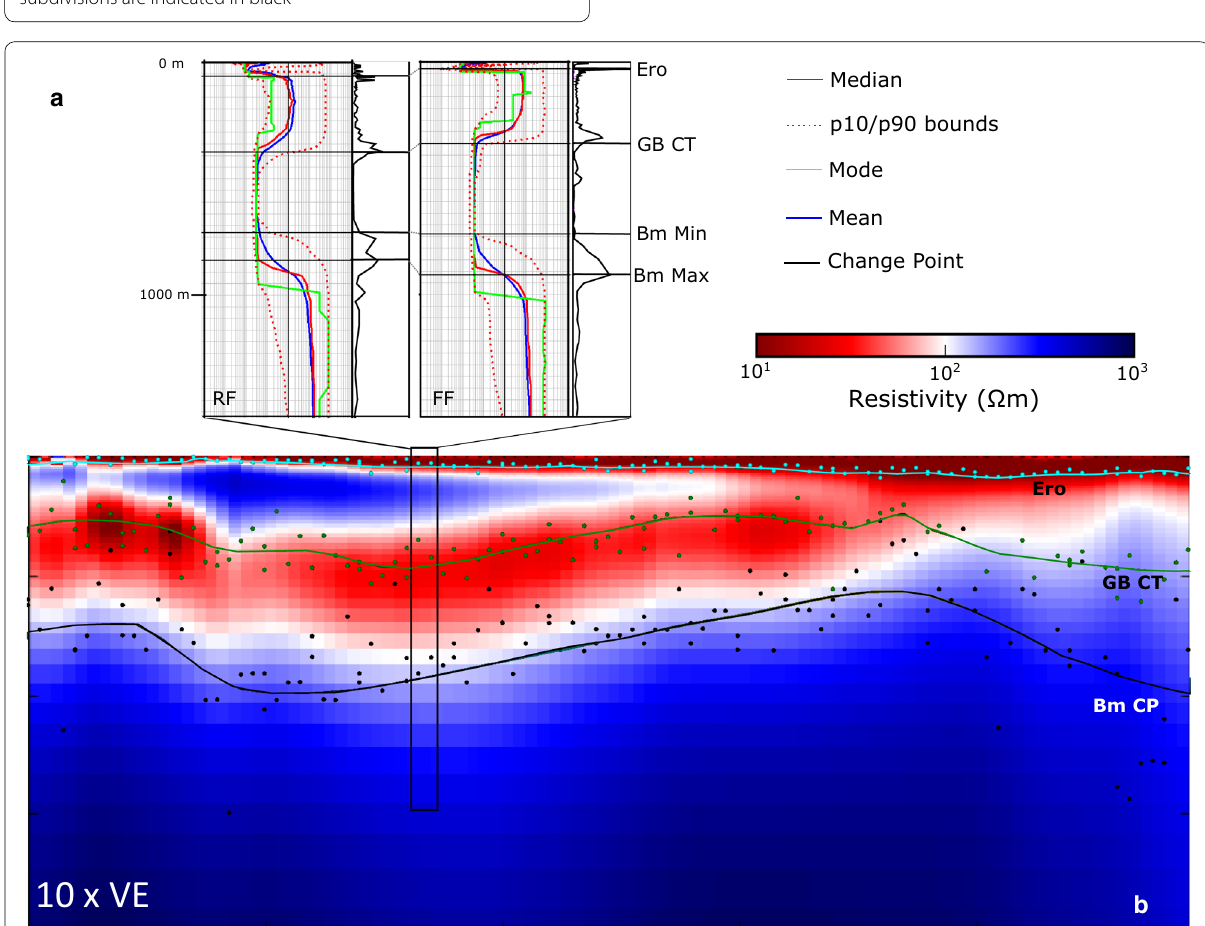
Fig. 10 Integrated 1D and 2D inversion interpretation summary. a Two rj-McMC inversion results as displayed in Geolog ® with associated picks. b Picks from 1D inversions shown as points for Bm CP, Ero and GB CT layers with associated interpretation surfaces against the Occam 2D inversion result (coloured